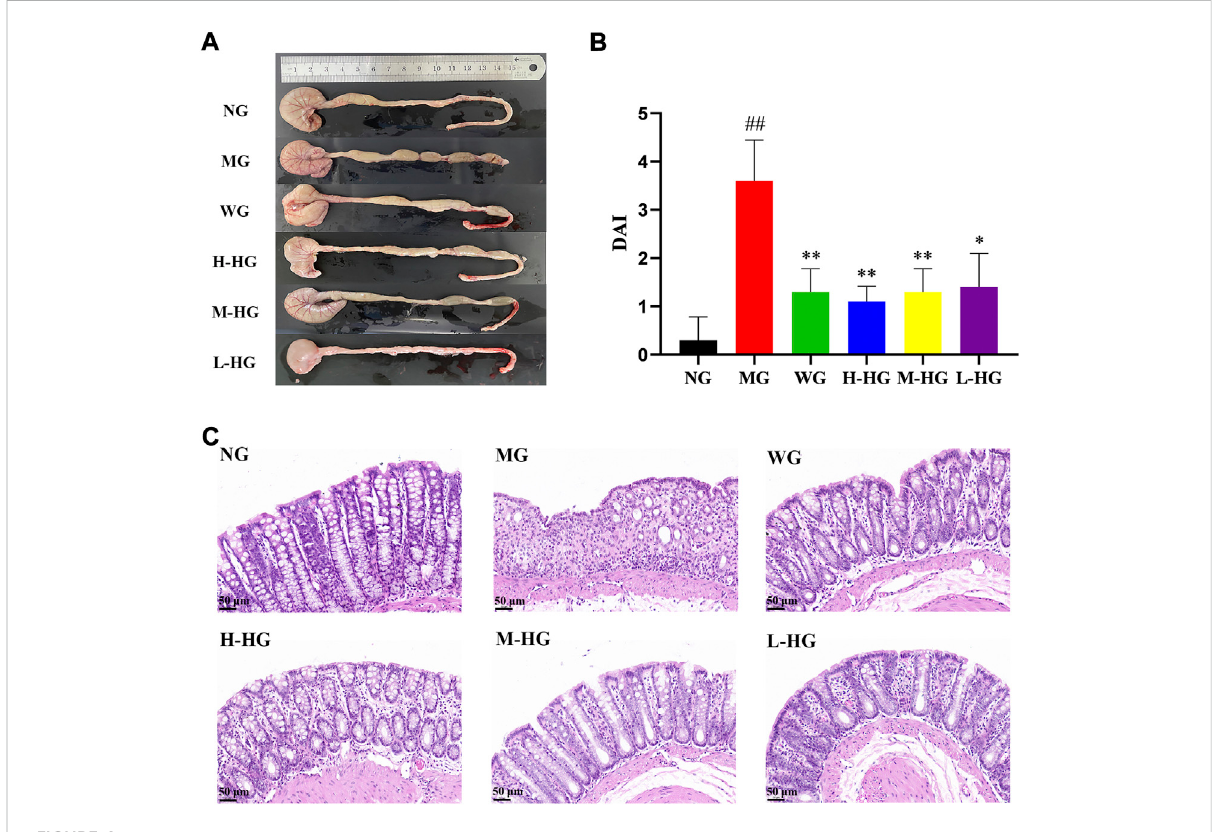
FIGURE 4 HZJDD alleviated DSS-induced UC in rats. (A) The length of the colon in each group. (B) Disease activity index (DAI) in each group (n = 10). (C) Results of HE staining (×200) in colon tissues of each group. ## p < 0.01 vs NG, ** p < 0.01 or * p < 0.05 vs